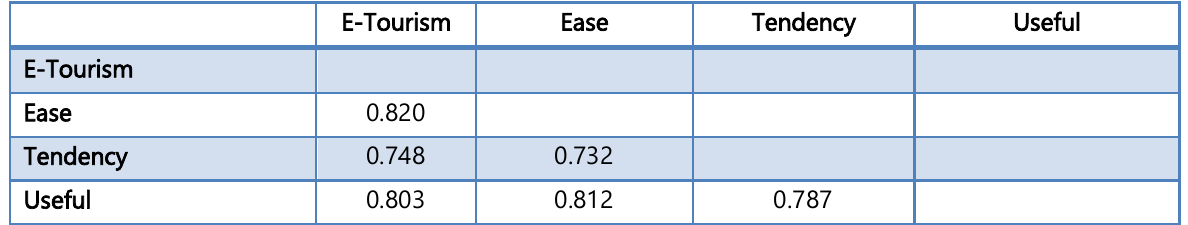
Table 3: Discriminant Validity (Source: Authors‘ depiction) Heterotrait-Monotrait Ratio